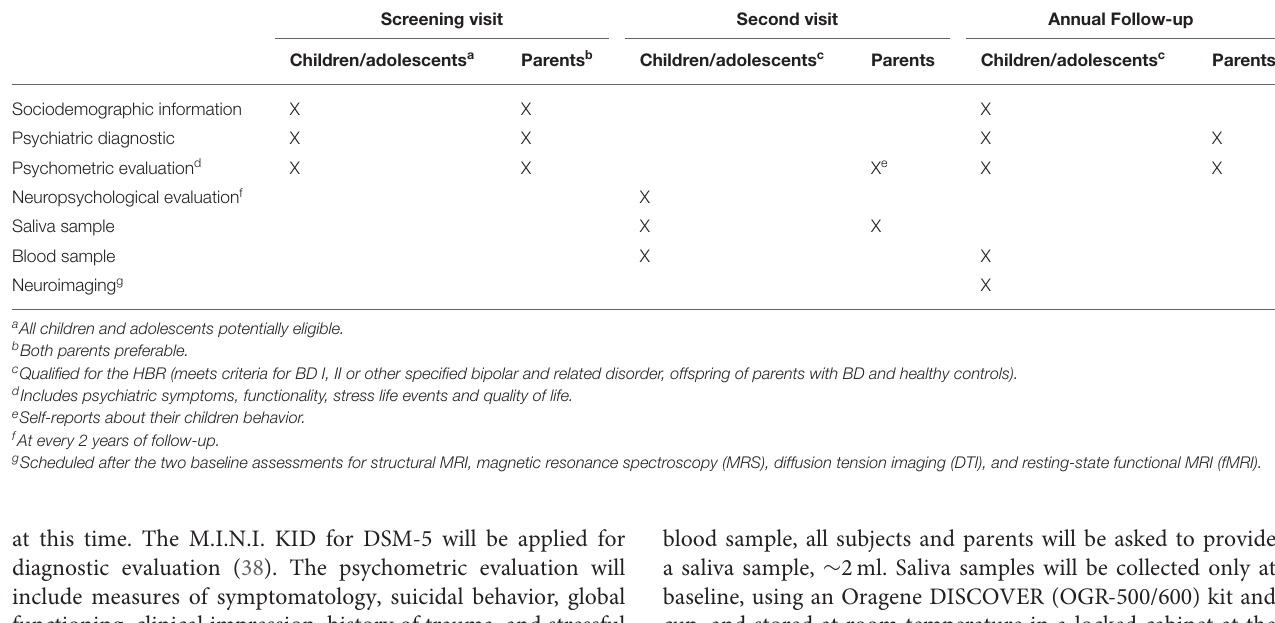
TABLE 1 | The greater Houston Area Bipolar Registry - summary of the assessments. Screening visit Second visit Annual Follow-up Children/adolescents a Parents b Children/adolescents